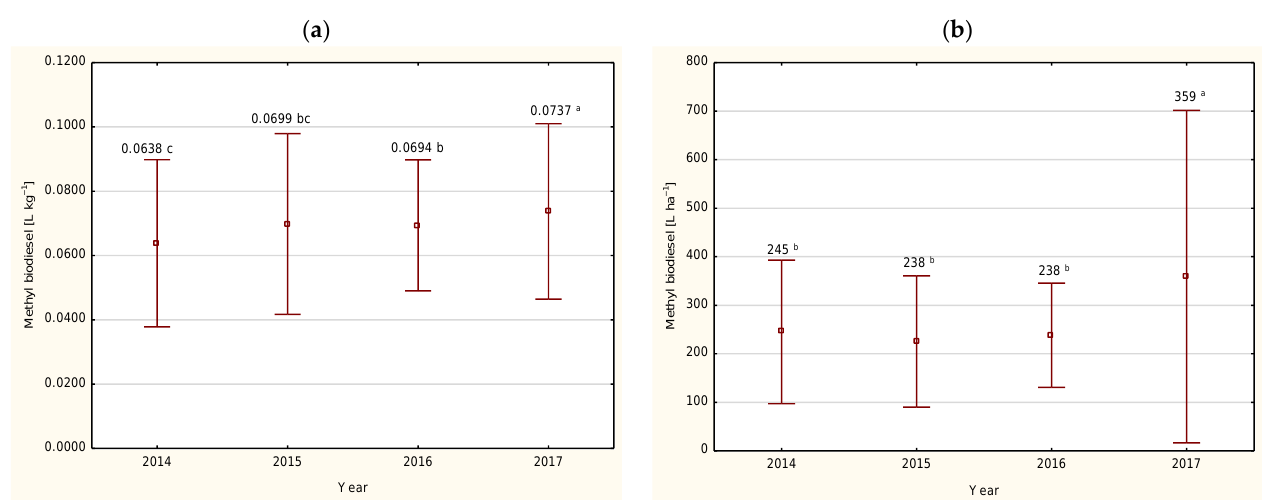
Figure 11. Volume of methyl biodiesel (mean value and standard deviation) obtained from corn grain ( a ) and bioethanol yield from a hectare ( b ), considering year of experiment. a,b,c — Values followed by the same letters do not differ significantly in Tukey’s (HSD) test ( p < 0.05).